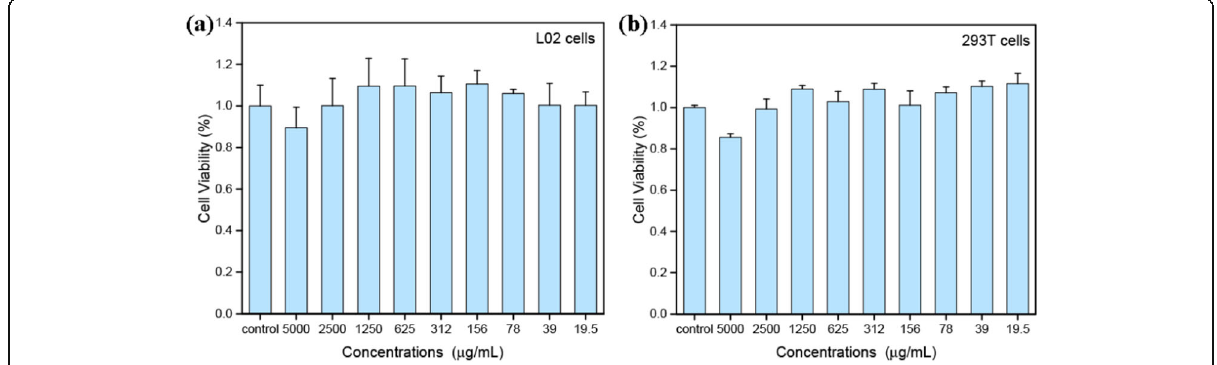
Fig. 4 Cell viability by CCK-8 assay of ( a ) L02 cells and ( b ) 293 T cells incubated with PCCC-CDs for 4 h